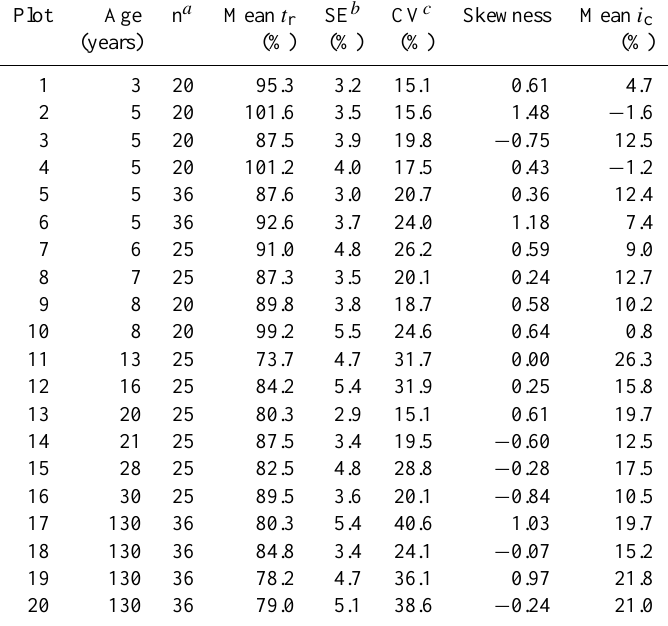
Table 1. Summary statistics of the throughfall